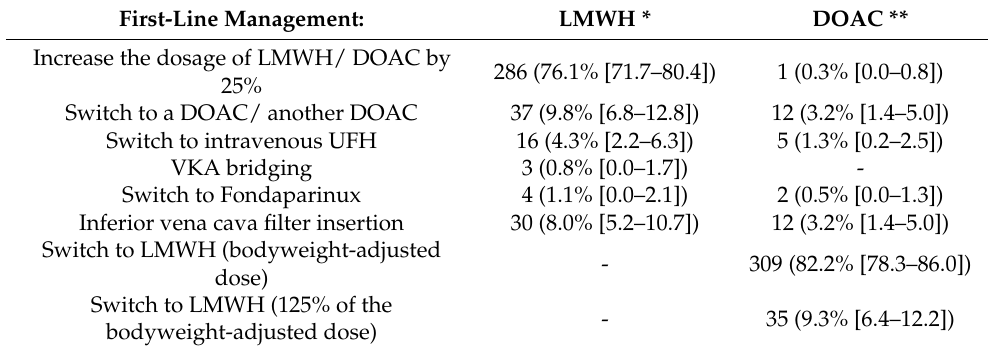
Table 4. Management of patients with VTE recurrence during anticoagulant